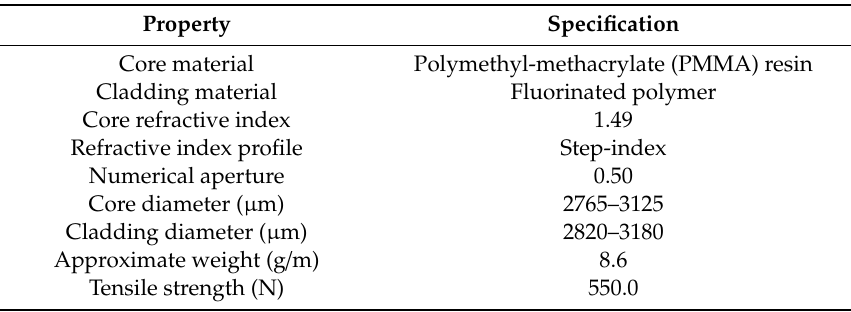
Table 2. Properties of the optical fibers (OFs) [17].